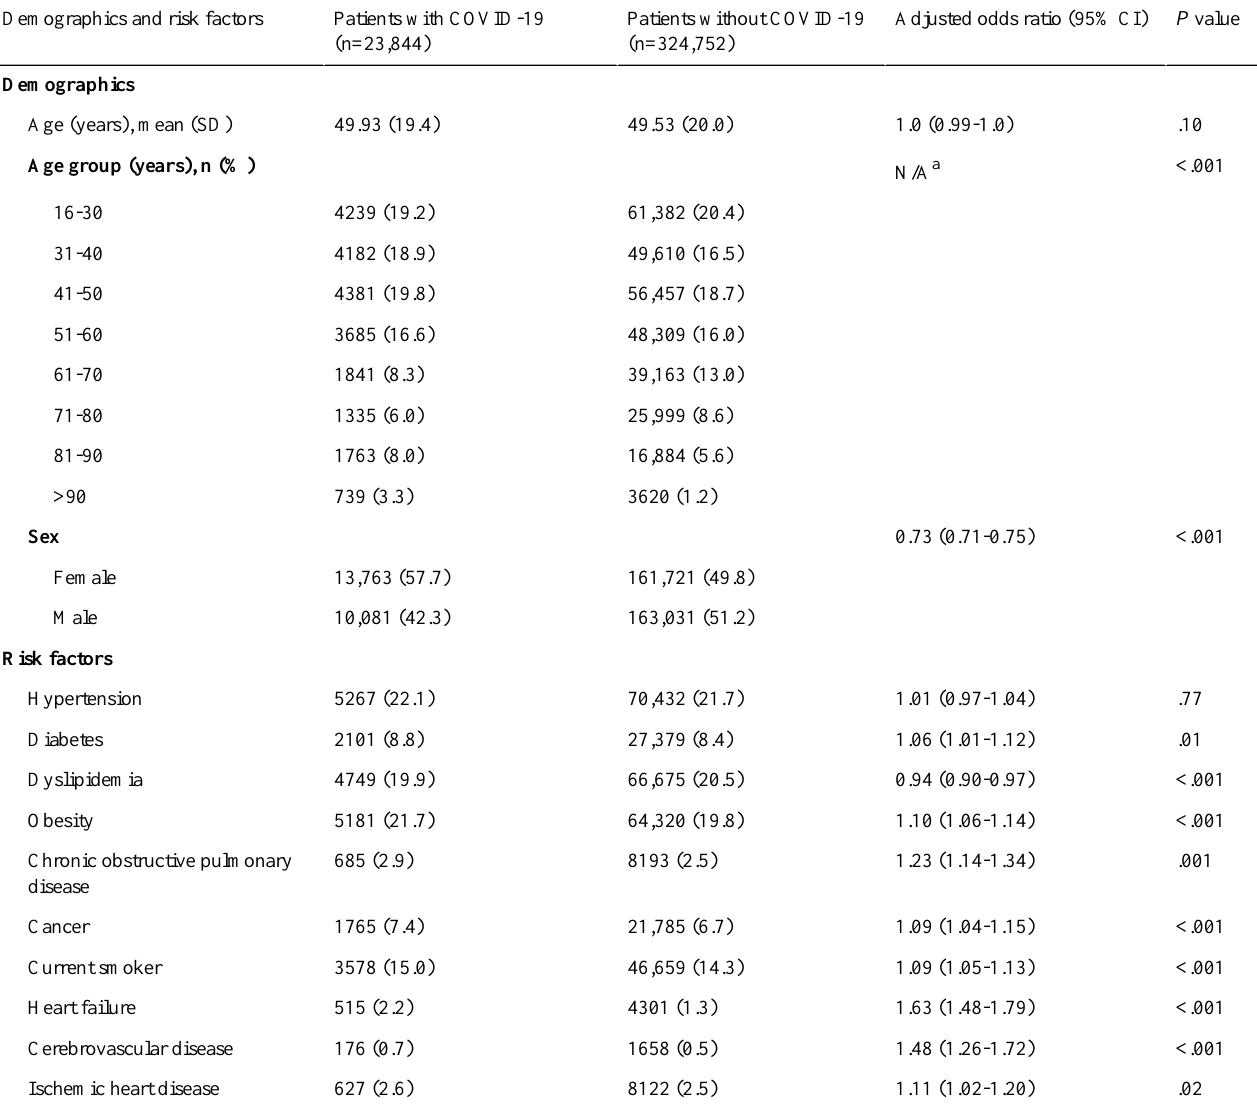
Table 1. Demographics and comorbidities of the study population, including patients with and without COVID-19 (N=348,596). Multivariate analysis of the risk factors was performed. Age was adjusted for sex and sex was adjusted for age. The remaining risk factors were adjusted for age and